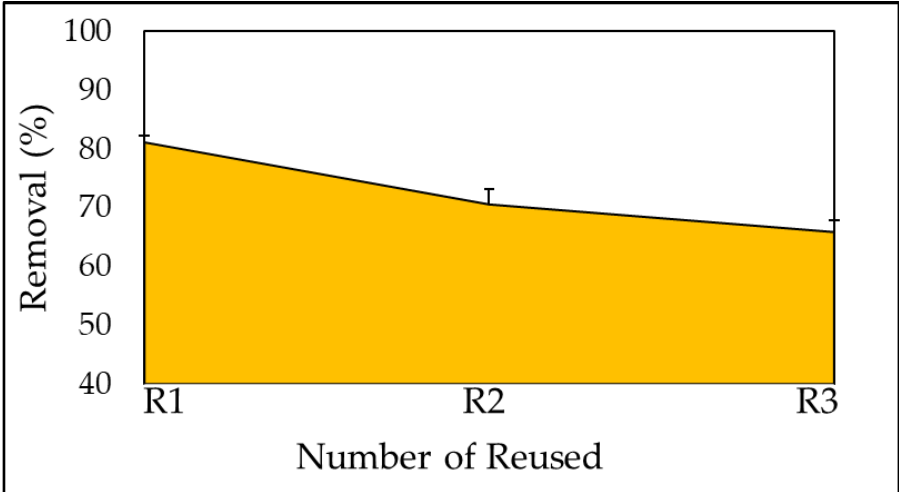
Figure 13. Reused of the adsorbent for removal of